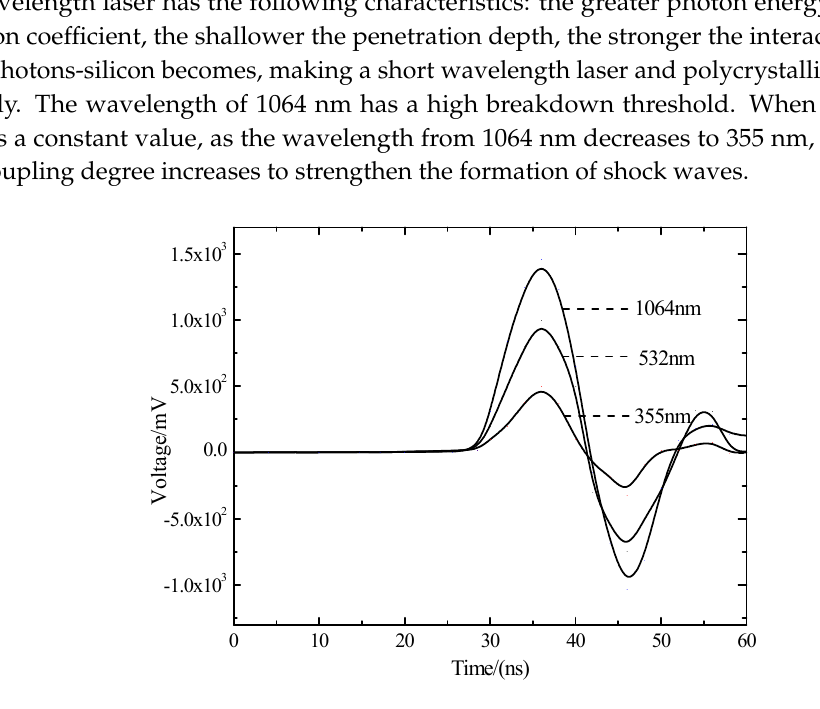
Figure 6. The laser shock wave piezoelectric signal of three different wavelengths.